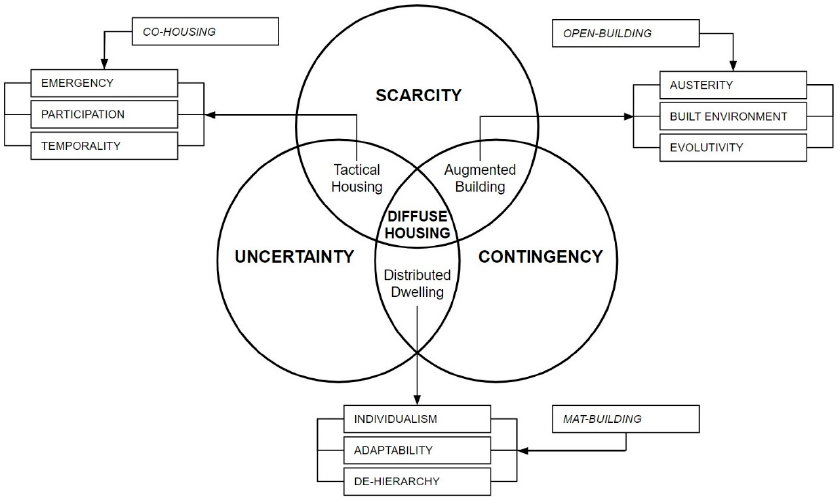
Figure 2. Theoretical hypothesis. Author’s own construction, 2020.